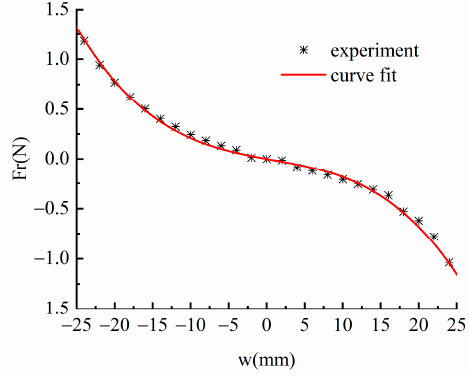
Figure 3. Restoring force